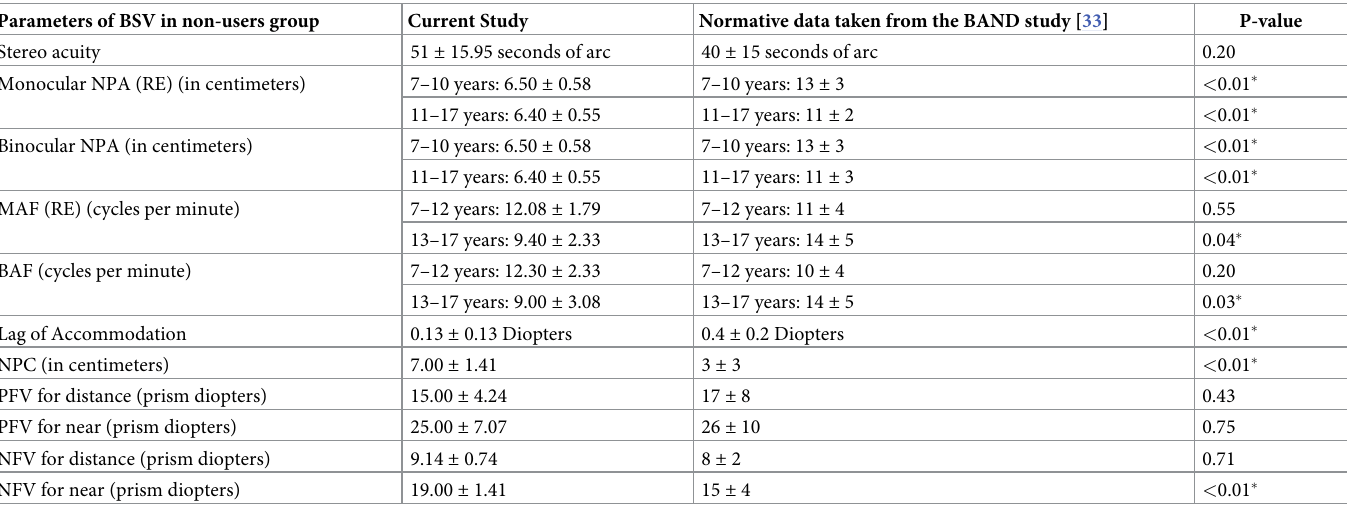
Table 1. Parameters of Binocular Vision (BSV) in non-users group.